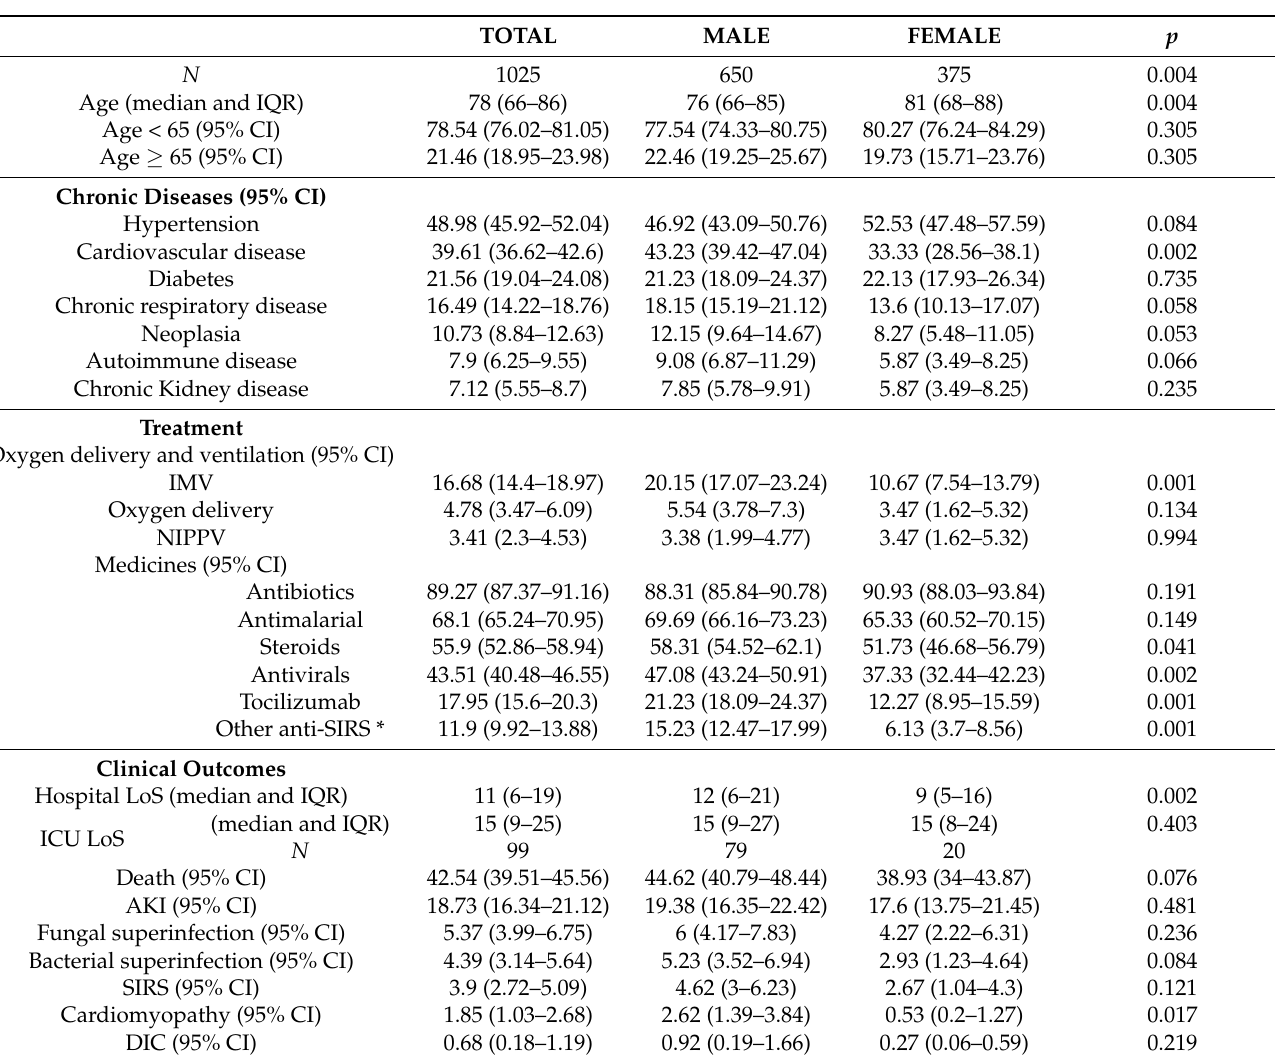
Table 2. Baseline characteristics and clinical outcomes of in-hospital COVID-19 patients with